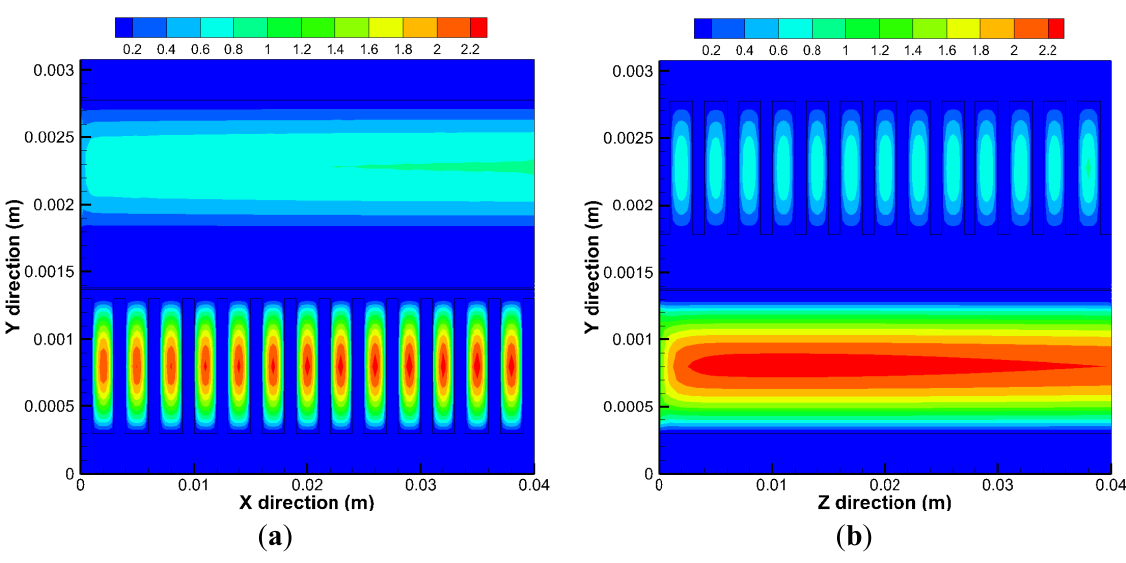
Figure 6. Velocity of the gas in different plane (not in scale): ( a ) y = 0.02 m; ( b ) x = 0.02